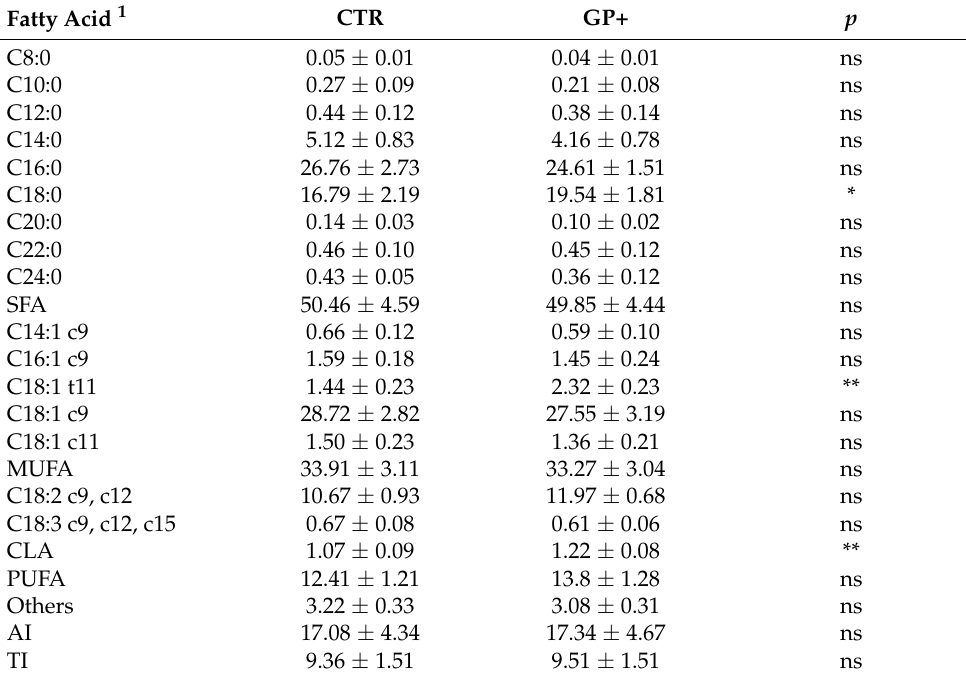
Table 4. Fatty acid profiles in meat samples obtained from lambs fed a standard diet (CTR) and lambs that received the dietary supplementation with grape pomace